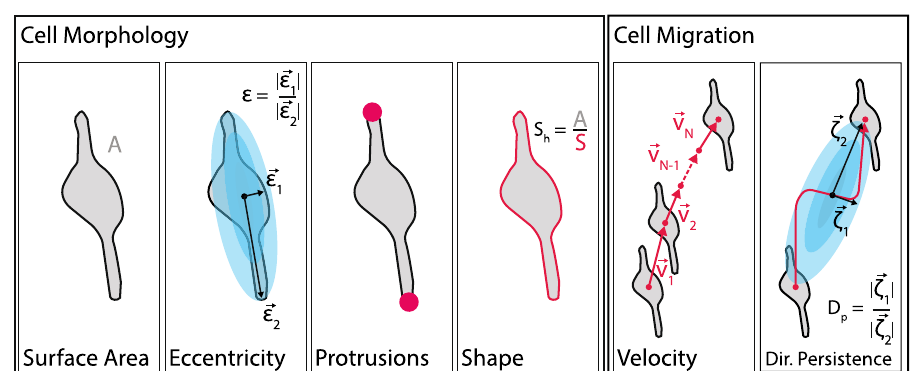
Figure 8. Cell properties. Descriptive properties of morphological cell activity components including cell surface area, cell eccentricity ( ε to perimeter ratio. Descriptive properties for cell migration are cell velocity derived from the cell vertex and directional